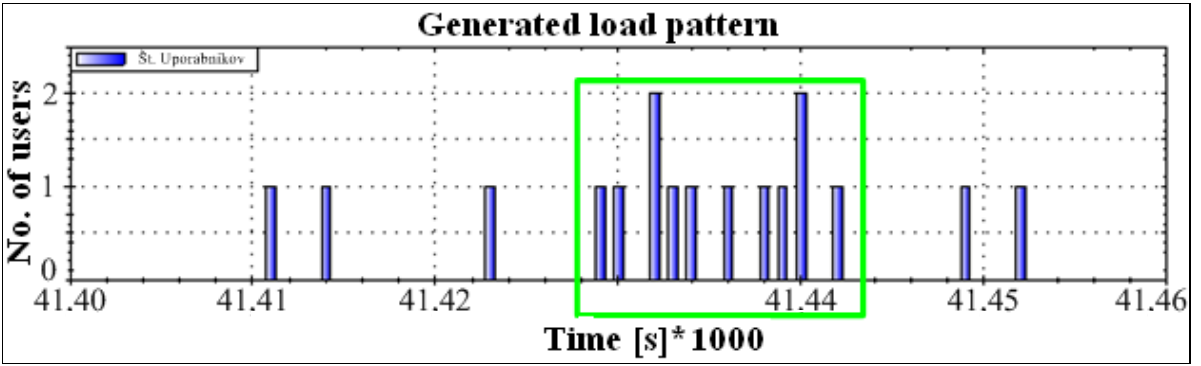
Figure 16. A random load pattern for a charging service system ( P = 15) for the number of users U = 17.